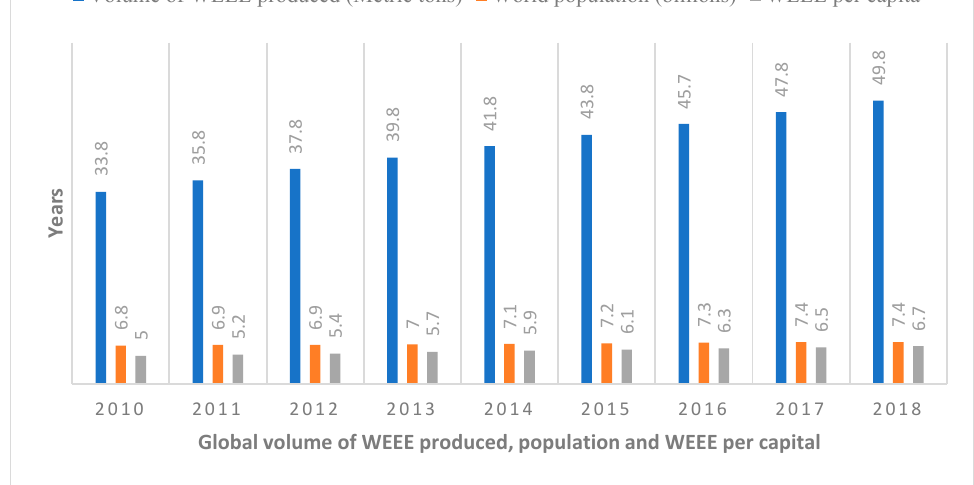
Figure 1. The projected amount of WEEE generated globally per year, population, and WEEE per capita.